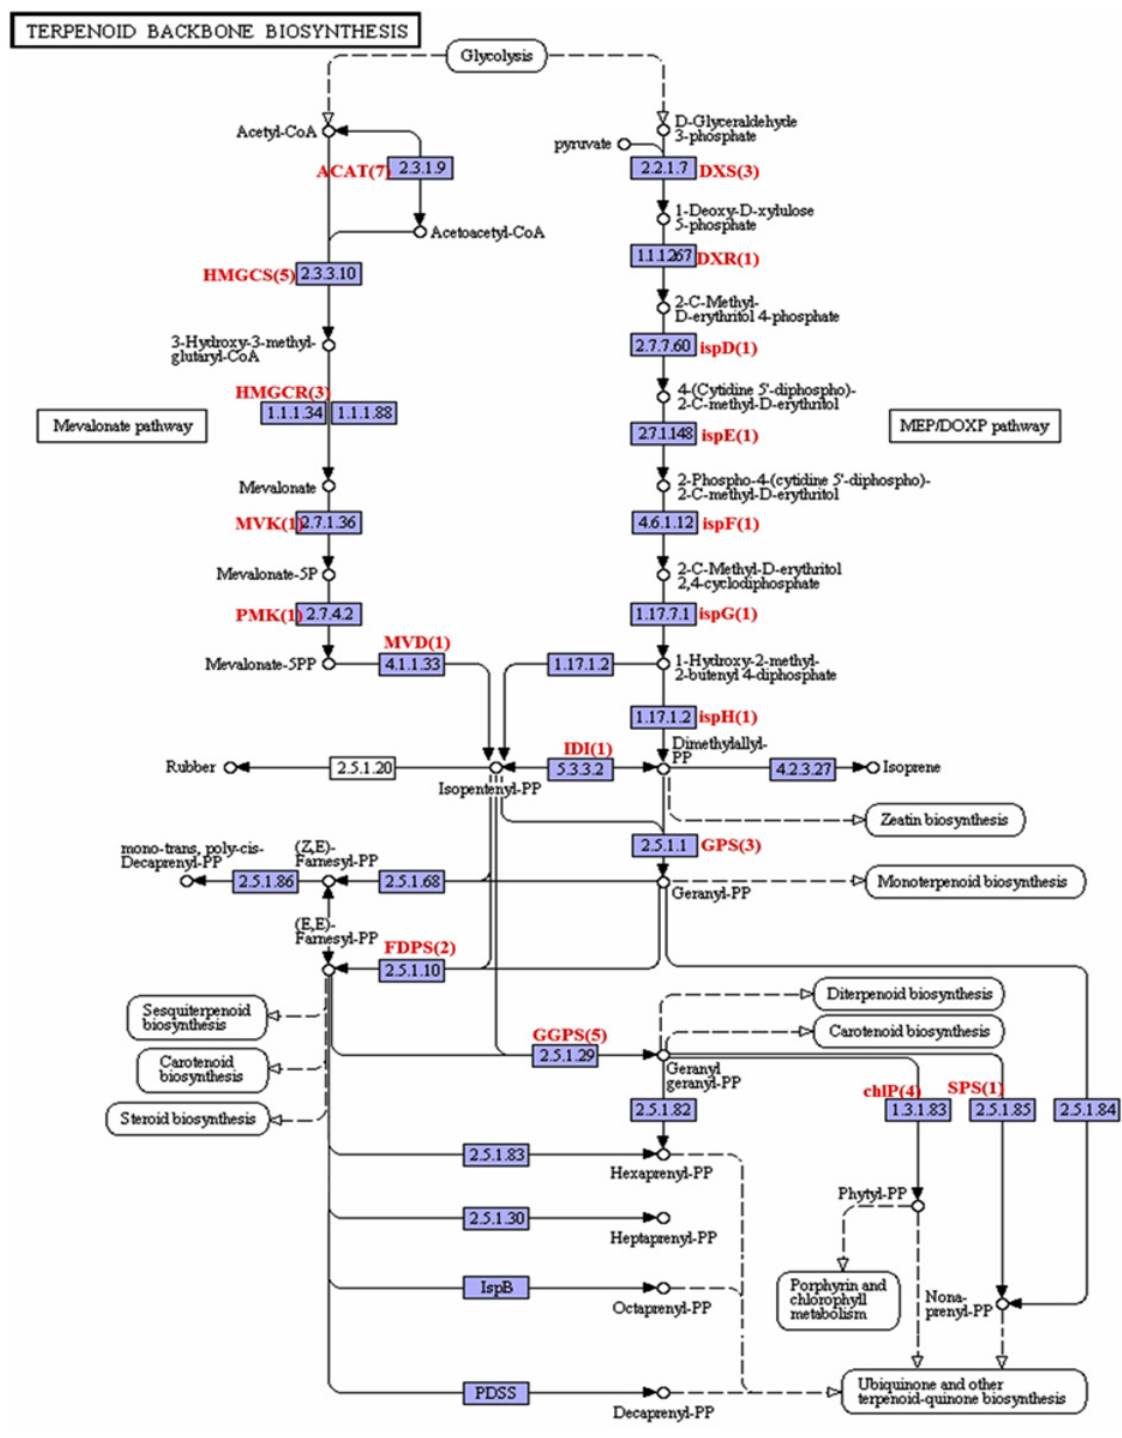
Fig 7. The Terpenoid backbone biosynthesis. The A . comosus var. bracteatus transcripts encoding enzymes (highlighted) involved in the pathway was identified by BLASTx (E-value of less than 10 -5 ). Numbers in bracket are the total number of unigenes encode for the enzyme.